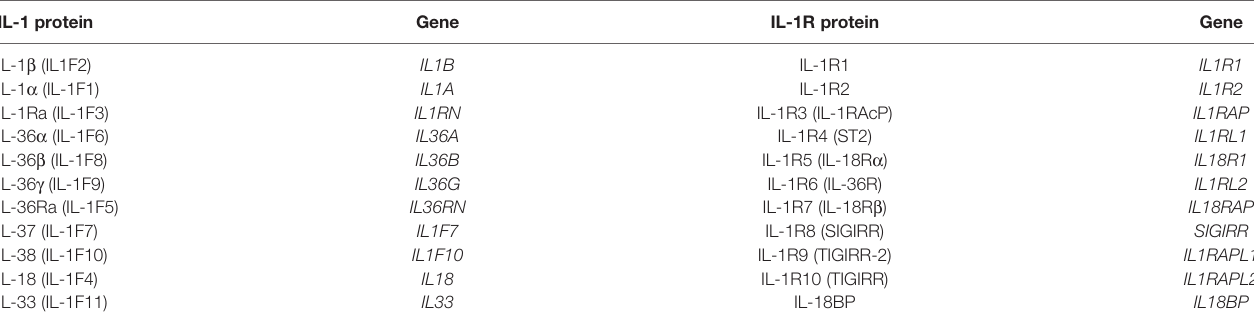
TABLE 1 | Human IL-1 and IL-1R protein and gene names*. IL-1